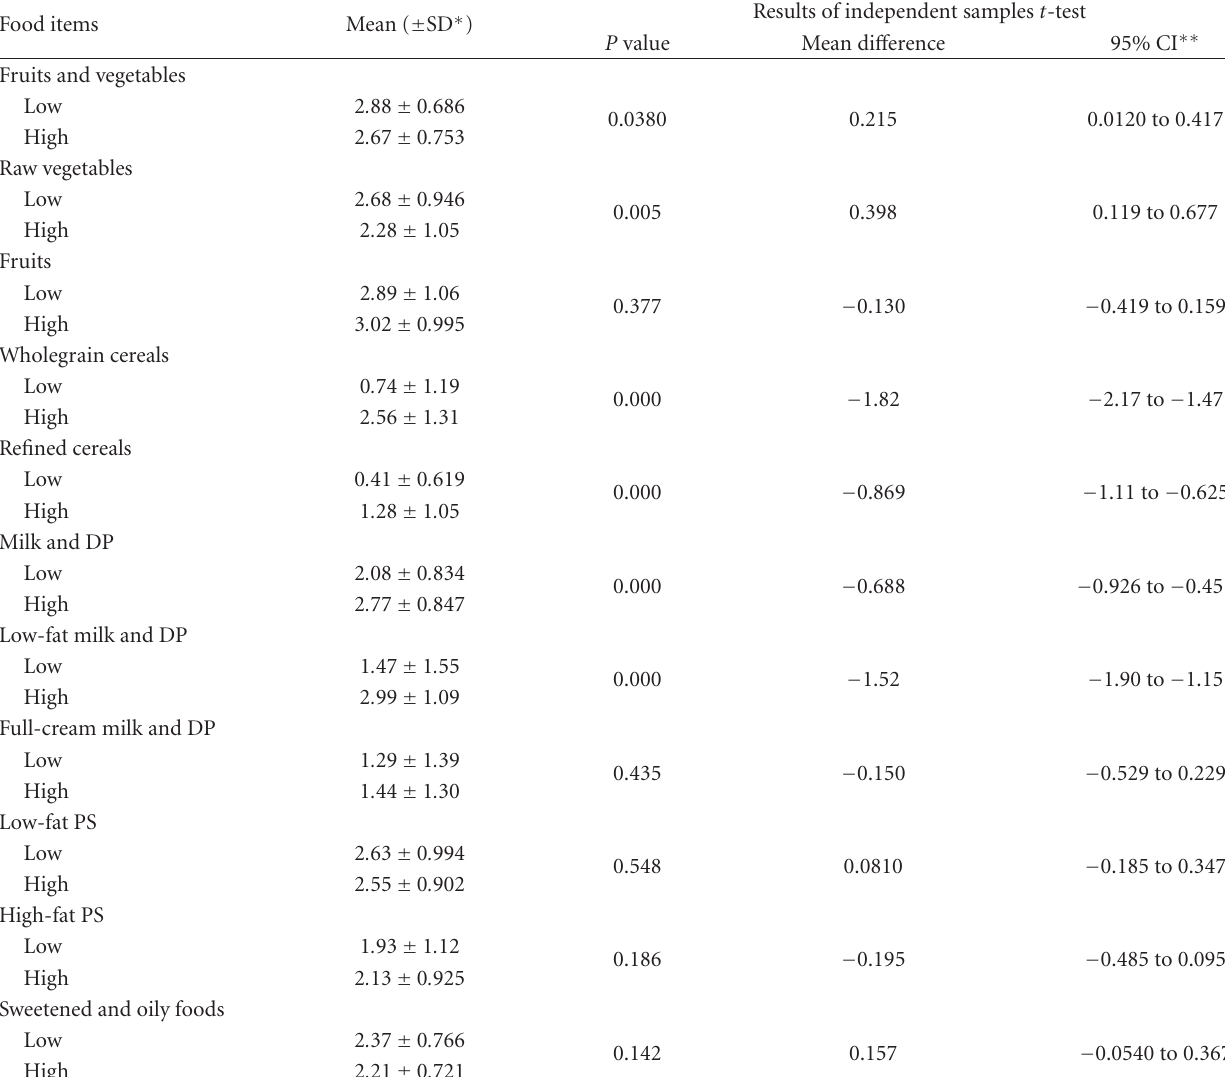
Table 3: Consumption frequencies of di ff erent food items by low and high socioeconomic